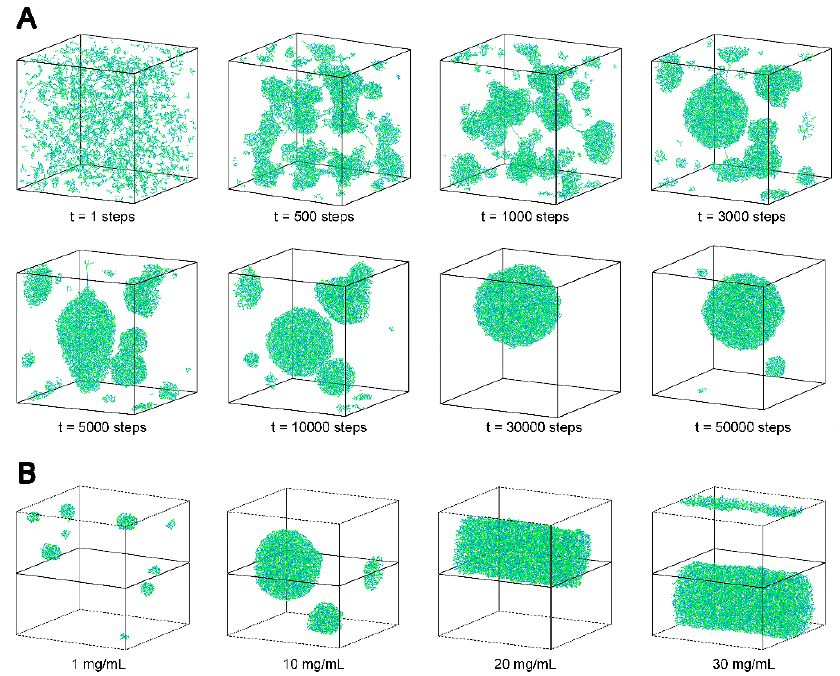
Figure 5. Simulation of the solution behavior of As sP. ( A ) The simulation of solution behavior of As sP molecules over time. ( B ) The simulation of the equilibrium solution state of As sP molecules at different concentrations.